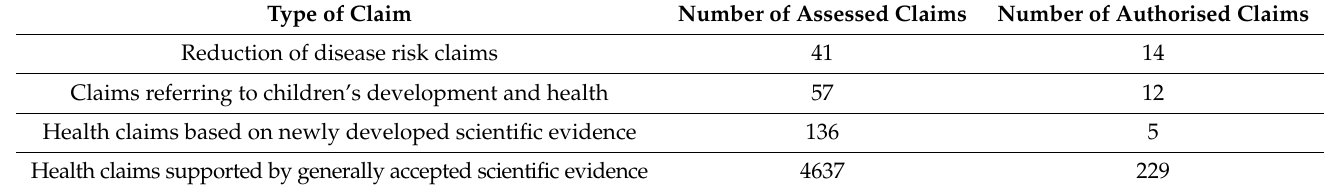
Table 2. Number of assessed health claims and number of authorised health claims in the EU (May 2022)